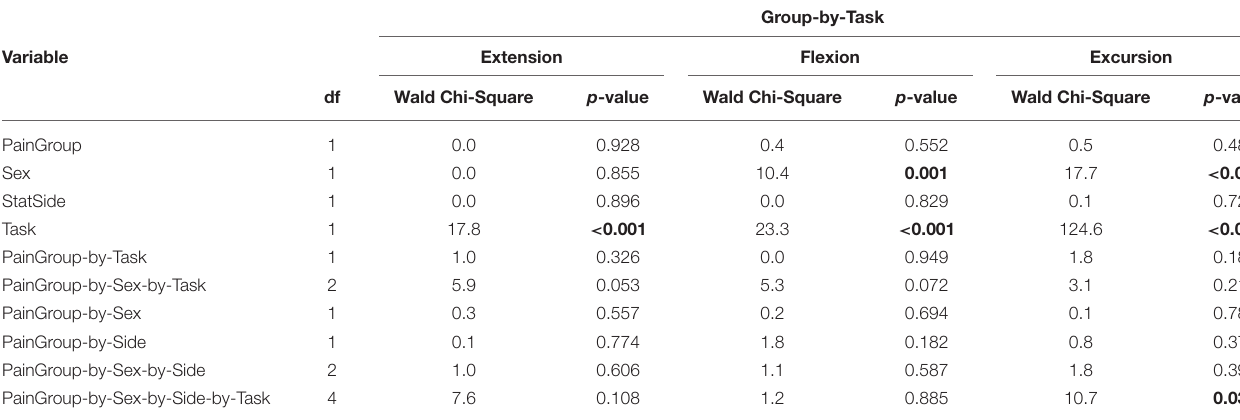
TABLE 6 | Results of linear regression with generalized estimating equation correction for each dependent variable (hip extension, flexion, and excursion) in individuals with PAHD modeling the interaction of PainGroup (pain with walking, no pain with walking) and Task (preferred speed, fast